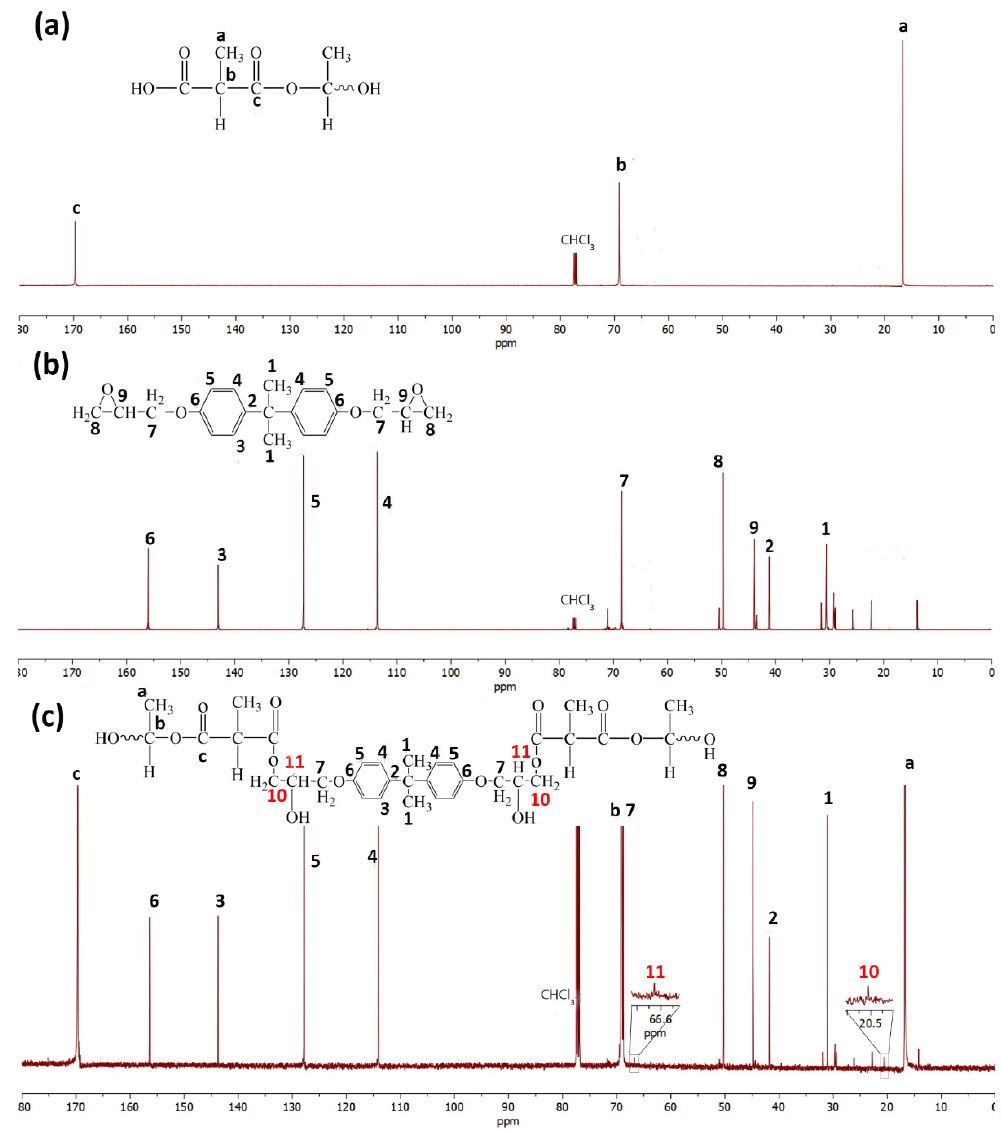
Figure 5. 13 C NMR spectra and structures of ( a ) neat PLA, ( b ) epoxy, and ( c ) the PLA/epoxy20 blend.